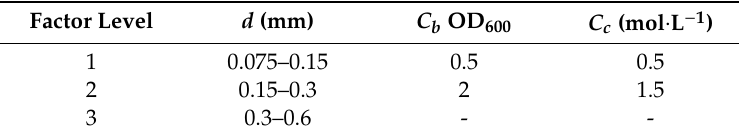
Table 2. The horizontal values of the factors in the orthogonal test.